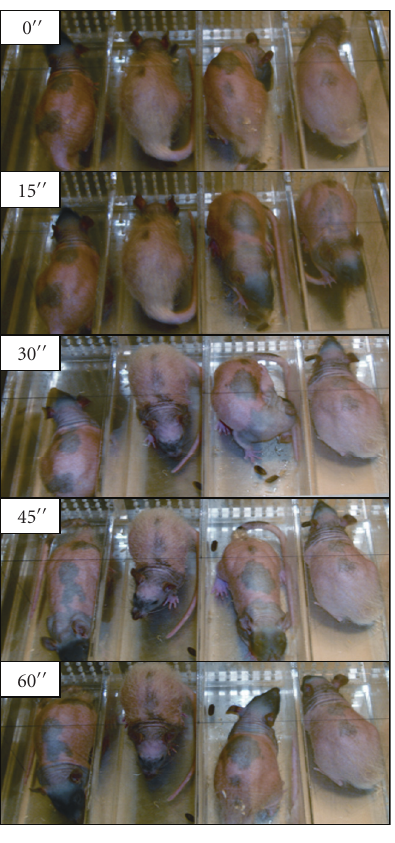
Figure 2: Movement of rats in a common cage. Possible changes in the position of rats sitting in the common cage during WBI are presented. Corresponding times are noted in seconds.